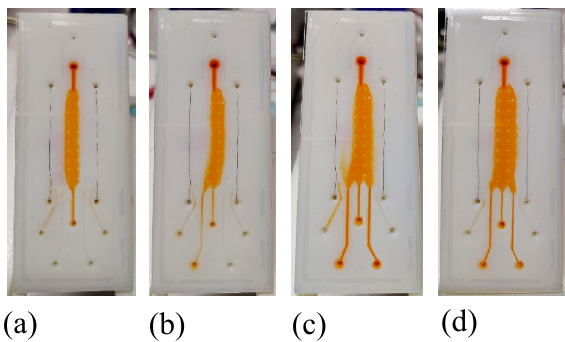
Figure 5. Optical photograph of the buffer flow confinement into the separation chamber: ( a ) buffer flow rate 20 µL/min and analyte flow rate 10 µL/min, ( b ) buffer flow rate 10 µL/min and analyte flow rate 10 µL/min, ( c ) buffer flow rate 10 µL/min and analyte flow rate 5 µL/min and ( d ) buffer flow rate 5 µL/min and analyte flow rate 5 µL/min.